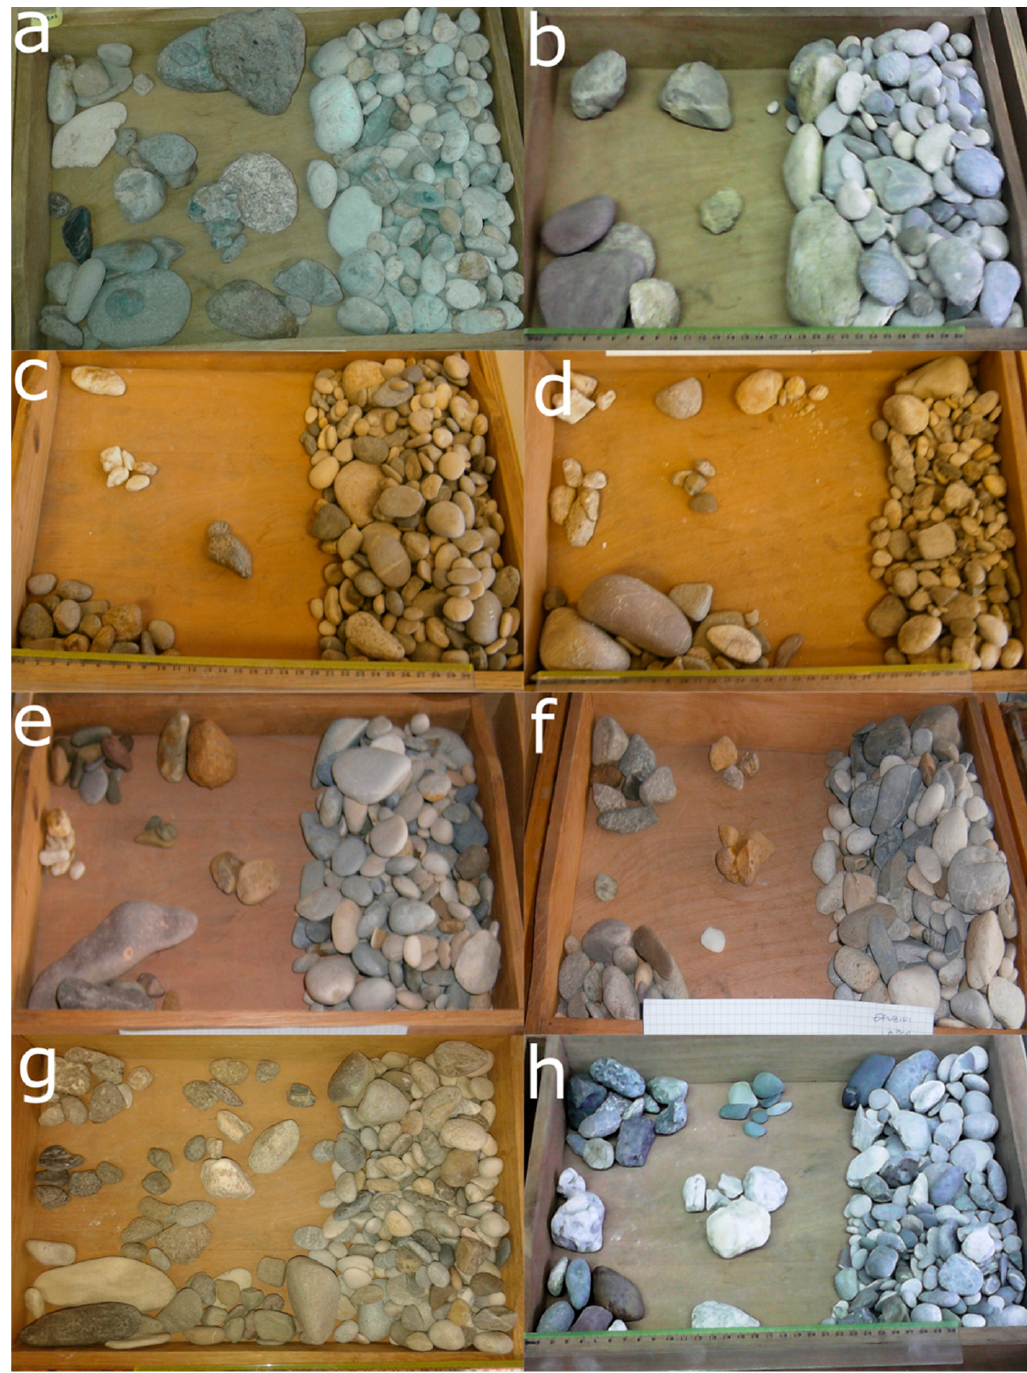
Figure 3. Analysed pebbles grouped into lithotypes, at locations: a —Samobor; b —Savrš ć ak; c —Orešje; d —Novo Č i č e1; e —Novo Č i č e2; f —Novi Petruševec1; g —Novi Petruševec2; h —Ivanja Reka. The division on the yellow scale, visible on the lower width of panels b, c, d, and h, is in